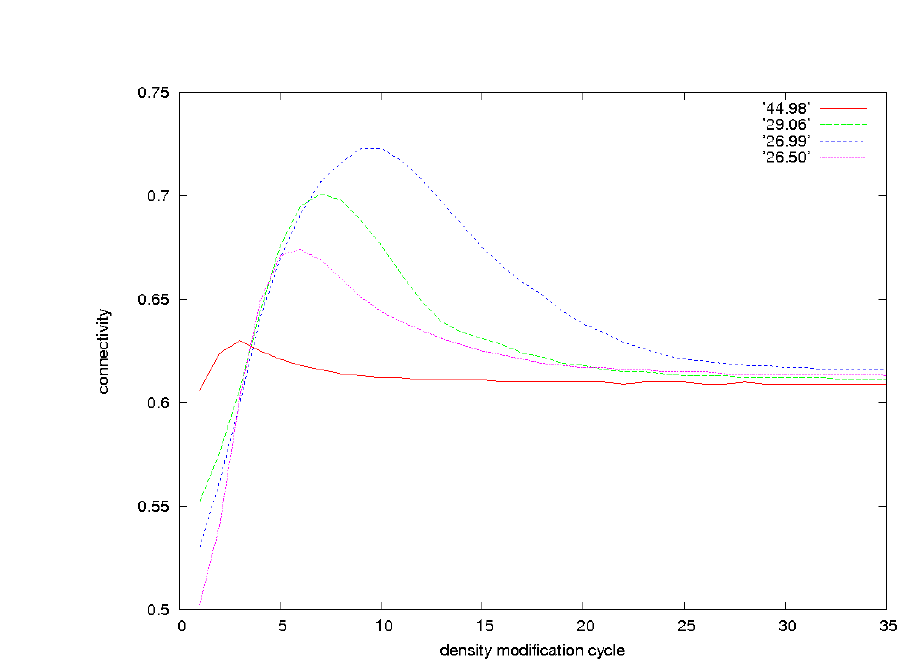
Figure 3. Connectivity calculated by SHELXE plotted by density modification cycle for Z-DNA for a range of tries based on the correlation